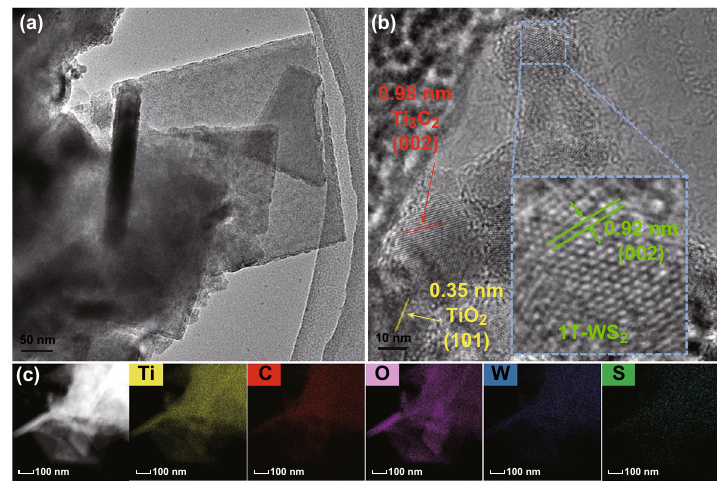
Fig. 3 a , b HRTEM and c EDX elemental mapping images of 1T-WS 2 @TiO 2 @Ti 3 C 2 composites (15 wt% WS 2